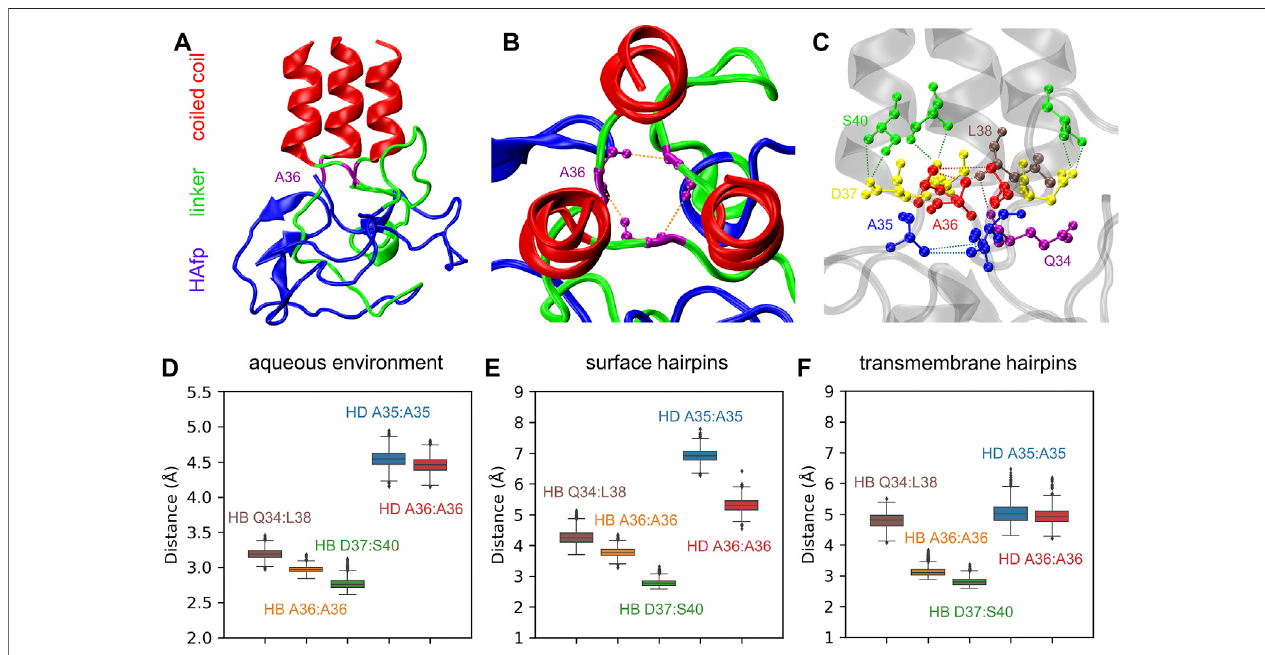
FIGURE 8 | (A) A fi nal structure of pillow-like HAfp assembly in an aqueous environment after 5 μ s simulation. (B,C) Main interactions stabilising the N-cap structure. (D – F) Donor-acceptor mean distances for hydrogen bonds (HBs) and methyl-methyl group mean distances for hydrophobic interactions (HD) within N-cap structures in simulations in pure water and with HAfp inserted to the lipid bilayer.